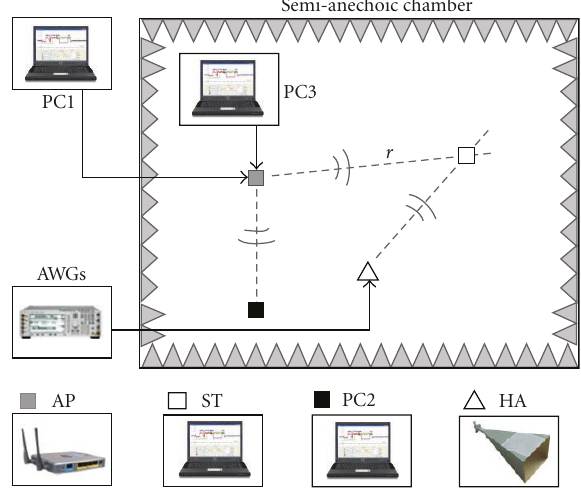
Figure 2: Second measurement scenario: adopted